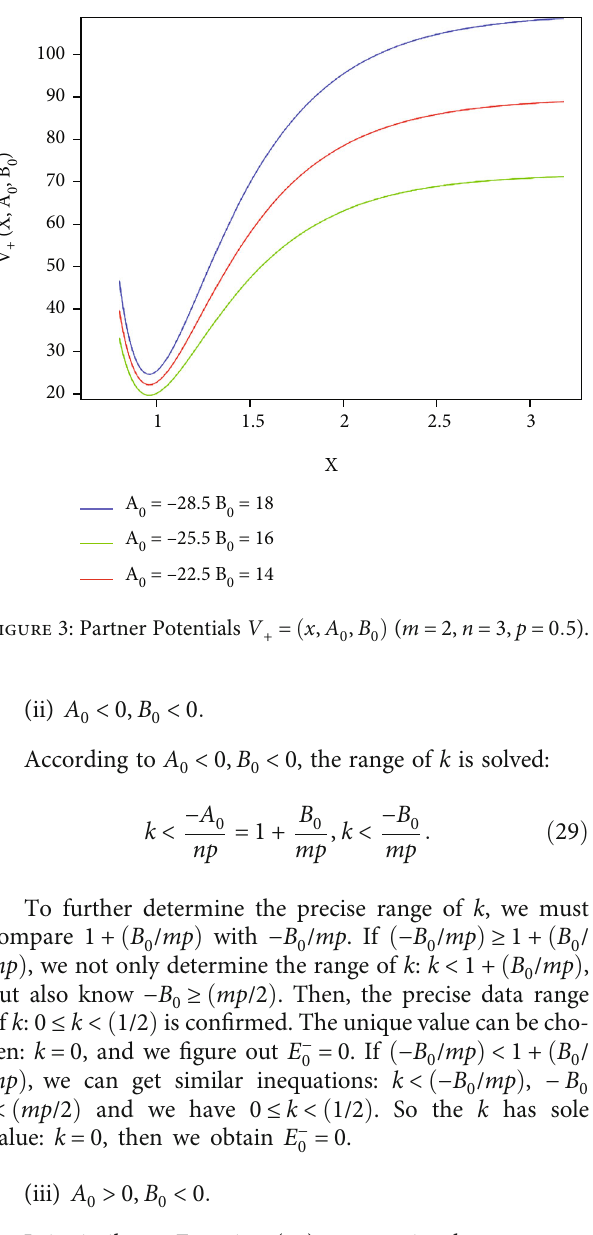
Figure 2: Superpotential W ð x , A , B Þ ( m = 2, n = 3, p = 0 : 5 ).